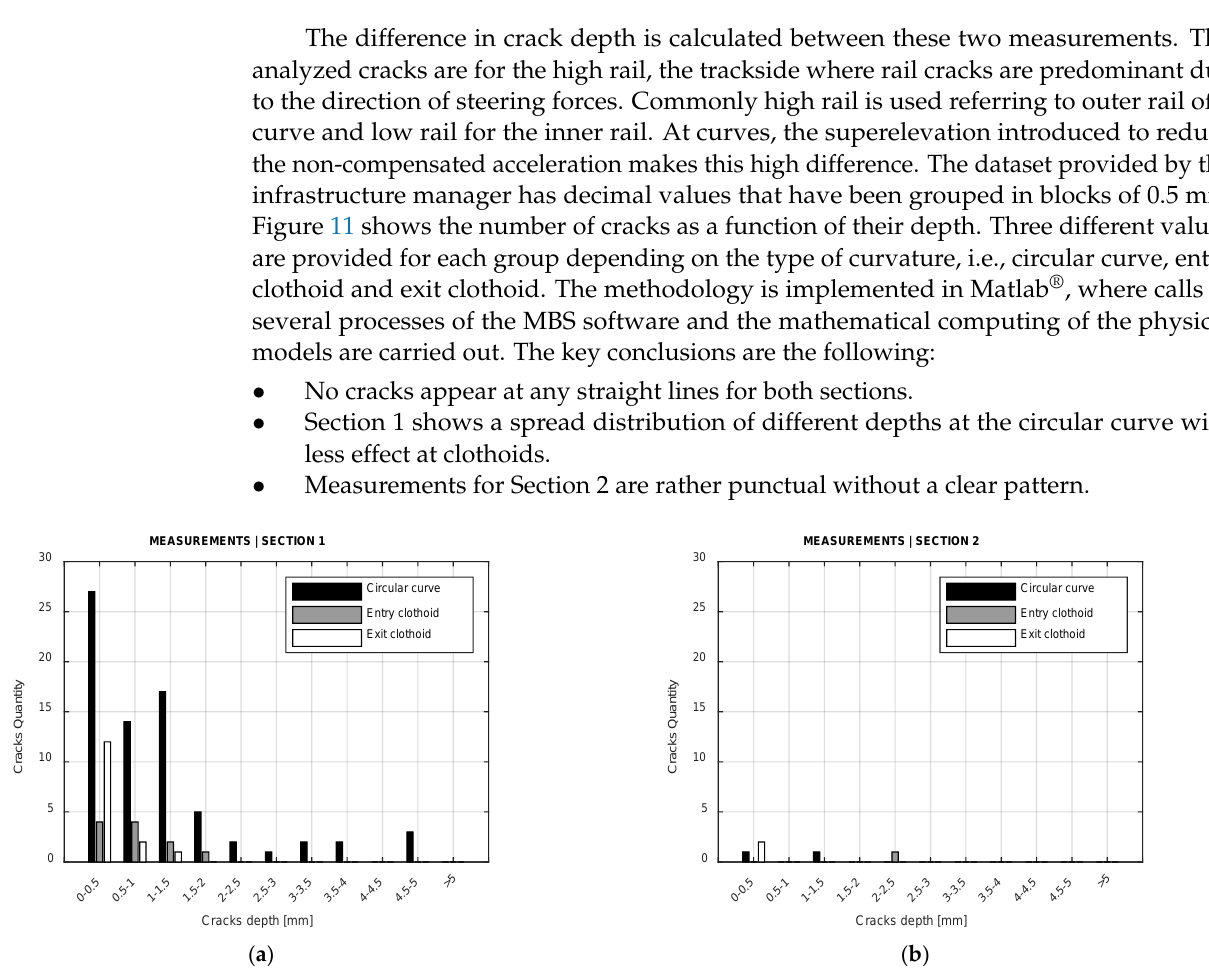
Figure 11. Number of cracks measured as a function of their depth, grouped by curvature type: ( a ) Section 1; ( b ) Section 2.